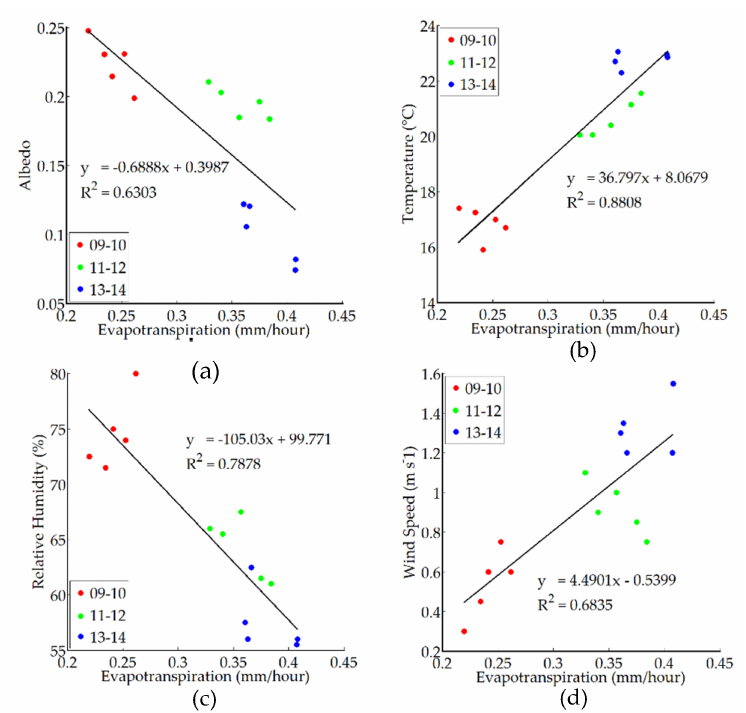
Figure 12. Correlation of hourly actual ET estimated from STAEFM TIR on 18 January 2019 with ( a ) albedo, ( b ) air temperature, ( c ) relative humidity, and ( d ) wind